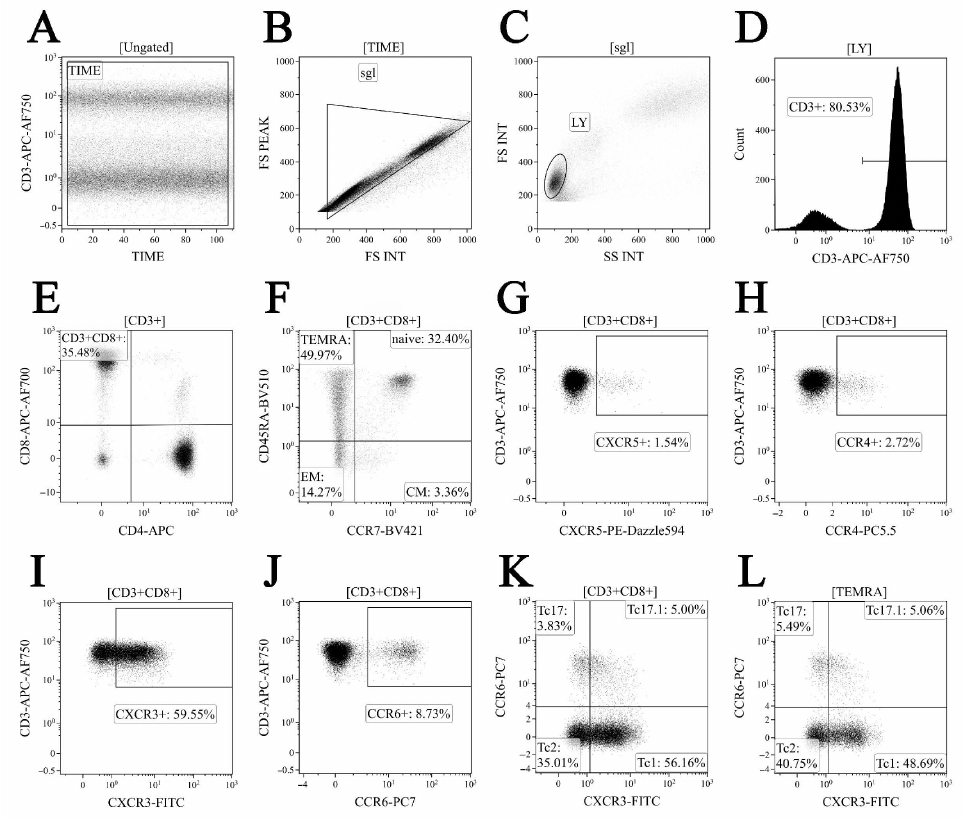
Figure 2. Gating and analysis strategy for ‘polarized’ CD8+ T cell subsets immunophenotyping using flow cytometry. Dot plot ( A )—artifact exclusion included time gating; dot plot ( B )—doublets exclusion from the analysis using the ratio between integral and peak forward scatter signals; dot plot ( C )—total lymphocyte subset purification based on side scatter and forward scatter; dot plot ( D )— total T cell subset gaiting based on CD3 expression; dot plot ( E )—detection of CD8+ T cells within total CD3+ T cell subset; dot plot ( F )—identification of four main CD8+ T cell maturation subsets: ‘naïve’, central memory (CM), effector memory (EM), and TEMRA CD8+ T cells; dot plots ( G – L